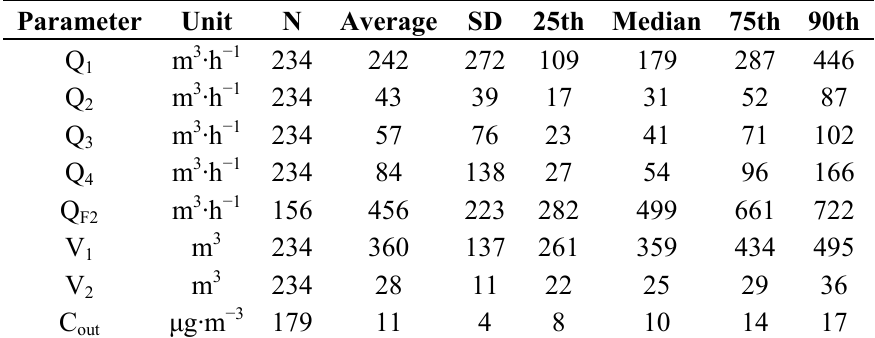
Table 4. Statistics of airflows for house (Q , V ), and outdoor PM concentrations (C volumes (V 1 2